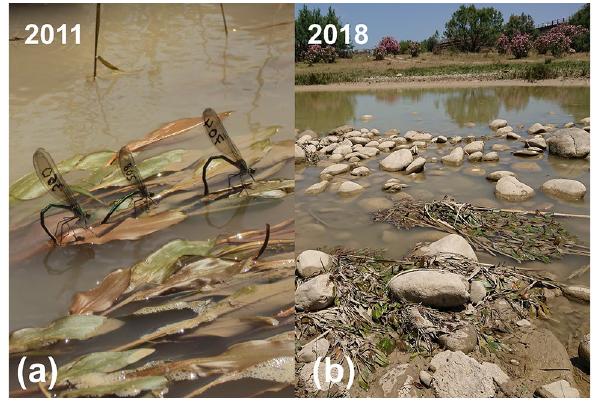
Figure 4. Reproduction of Calopteryx exul in the Seybouse River in 2011 ( a ) and a huge drop in water level of the river in 2018. Note that the patches of long-leaf pondweed ( Potamogeton nodosus ), a preferred oviposition site for the species, which typically float on the water surface are dry due to water abstraction (Credit: Rassim